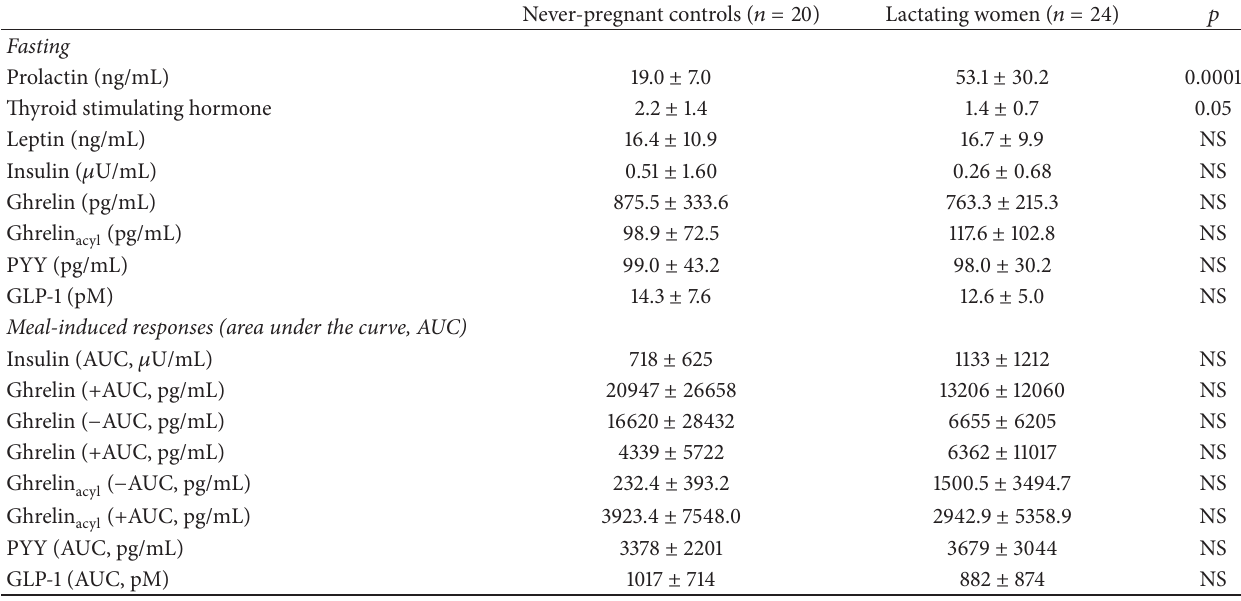
Table 2: Appetite-regulating hormones and other hormones during fasting and in response to a standardized meal.